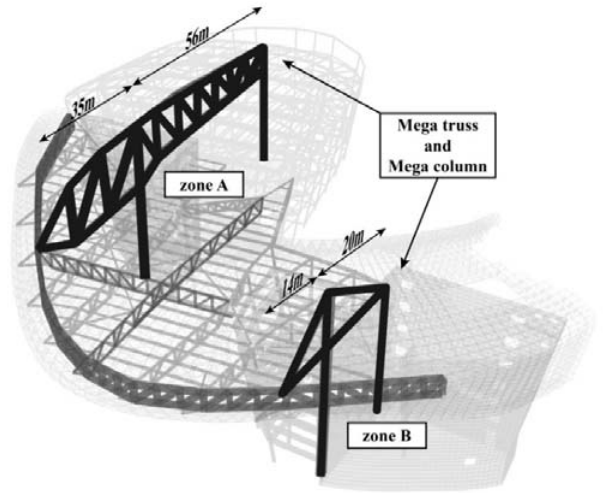
Figure 4. Structural